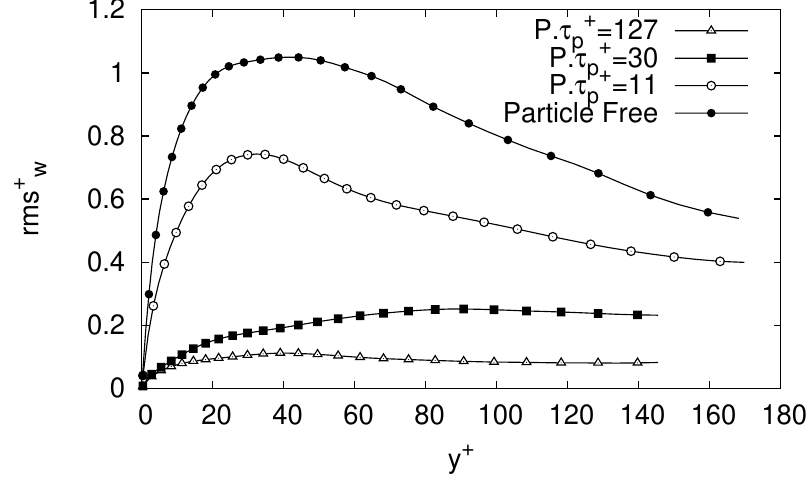
Figure 10. Comparison of rms + w profiles for all production cases.